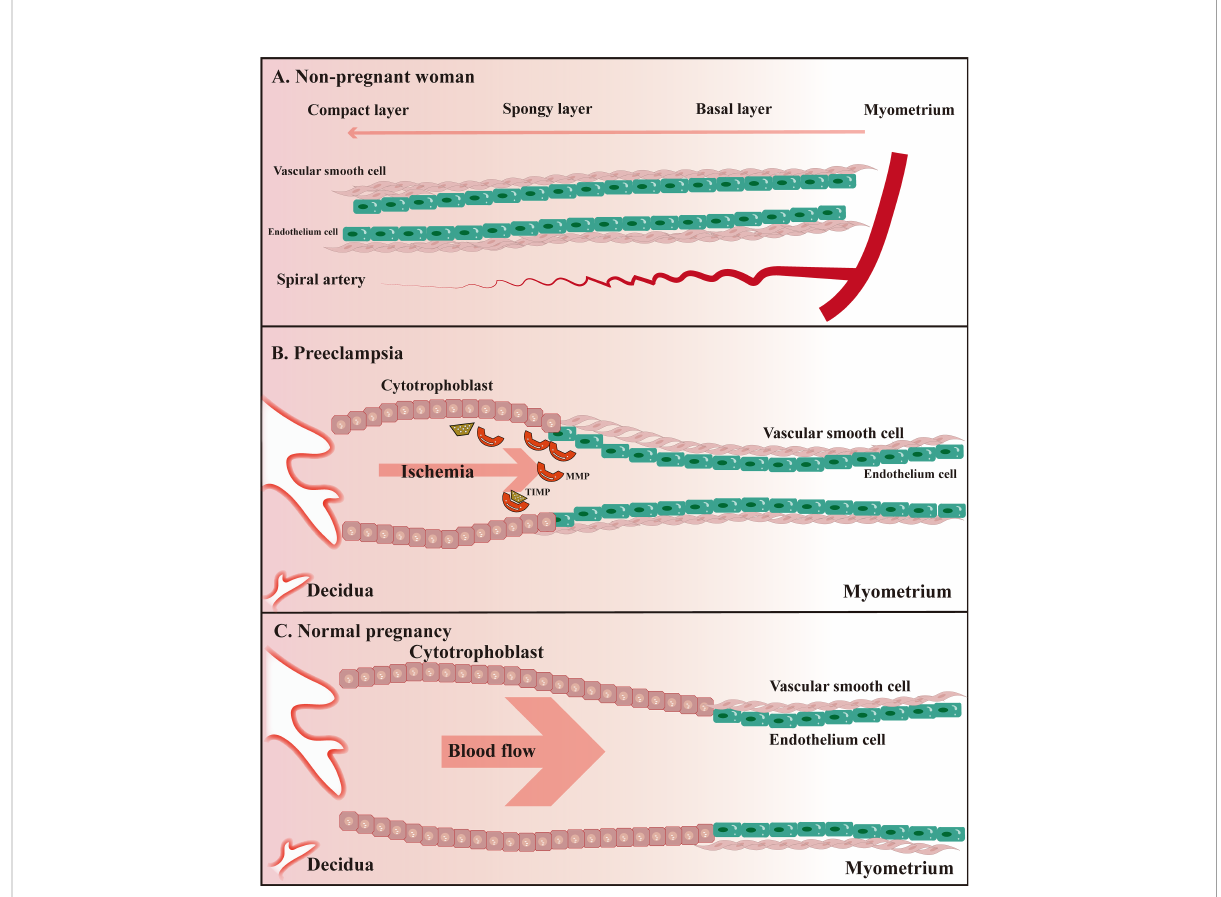
FIGURE 2 Schematic diagram of uterine spiral artery remodeling in non-pregnant women, PE, and normal pregnant women. (A) The uterine spiral arteries extend into the functional layer of the endometrium, of which the lumen diameter changes periodically under the in fl uence of ovarian hormone levels; (B) Remodeling of the uterine spiral arteries is insuf fi cient compared to normal pregnant women; (C) Physiological remodeling of the uterine spiral arteries is witnessed with the thickened spiral arteriole, enlarged lumen, and increased blood fl ow